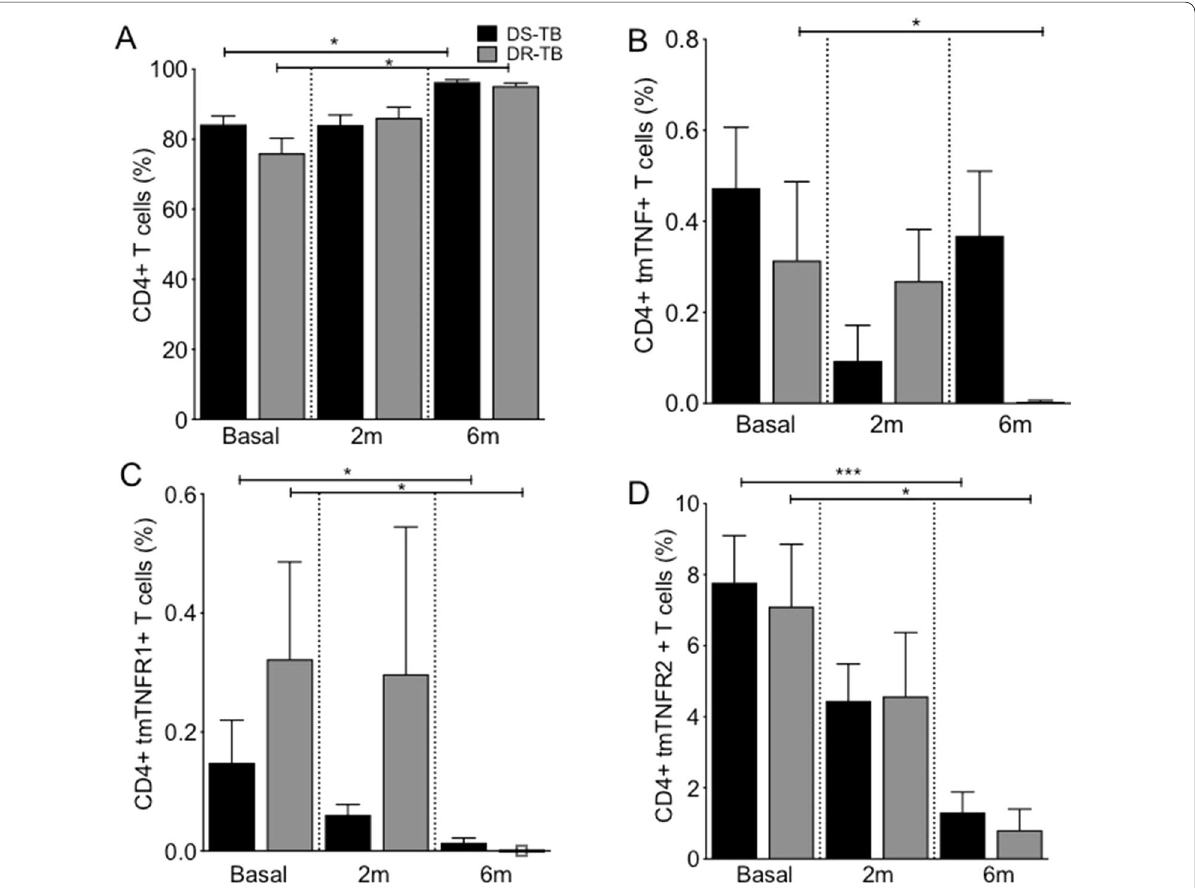
Fig. 4 In response to anti‑TB therapy, DR‑TB increases CD4 T cells but decreases the expression of TNF molecules pathway. Peripheral + mononuclear cells from drug‑susceptible (DS‑TB) and drug‑resistance (DR‑TB) tuberculosis patients were obtained at diagnosis time (basal), 2 months (2 m), and 6 months (6 m) of use of anti‑TB therapy, and then they were prepared for flow cytometry. For analysis, a gate of CD3 CD4 + + CD25‑Foxp3 cells (CD4 T cells) was identified. Then, the expression of tmTNF, tmTNFR1 and tmTNFR2 on CD4 T cell surface was evaluated. A − + + The frequency of CD4 T cells was obtained at basal, 2 m and 6 m of anti‑TB therapy. The frequency of CD4 T cells positive to tmTNF ( B ), tmTNFR1 + + ( C ) and tmTNFR2 ( D ) was evaluated. DS‑TB n 11, DR‑TB n 7. Bar graphs show the mean SD. One Way ANOVA with Dunn’s post‑test multiple = = ± comparisons tests (*p < 0.05, ***p <